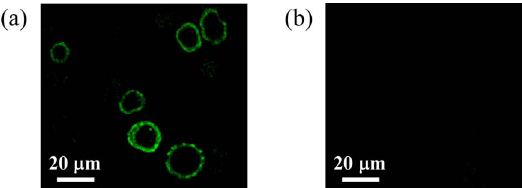
Fig. 2 Immunofluorescence images of infected and uninfected cells. (a) Infected cells. (b) Uninfected cells. The plasma membrane of the infected cells was stained while that of the uninfected cells was